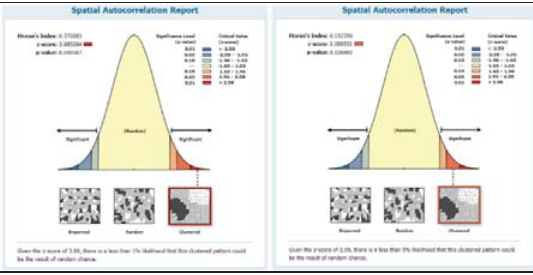
Figure 8. Residual map for OLS with interpolation (left) and without interpolation (right)